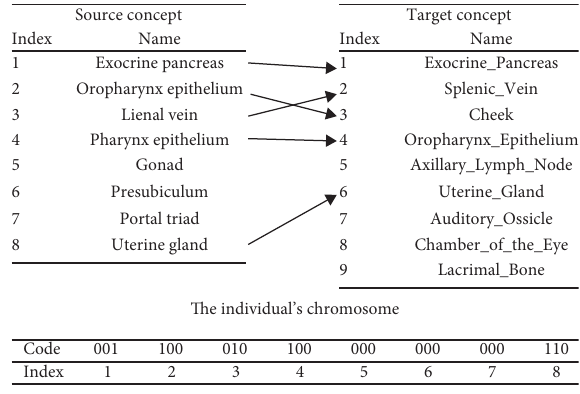
Figure 1: An example of the encoding mechanism.